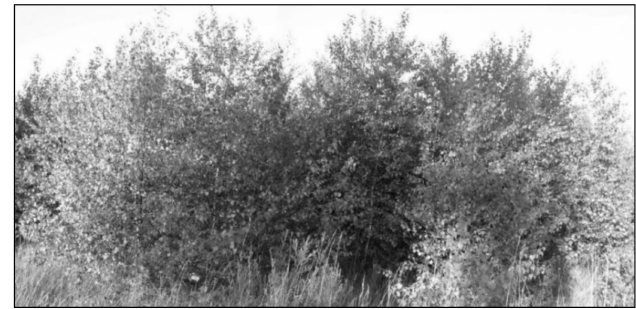
Figure 10. Young Silver birch stands (photo by Arvydas Urbis).